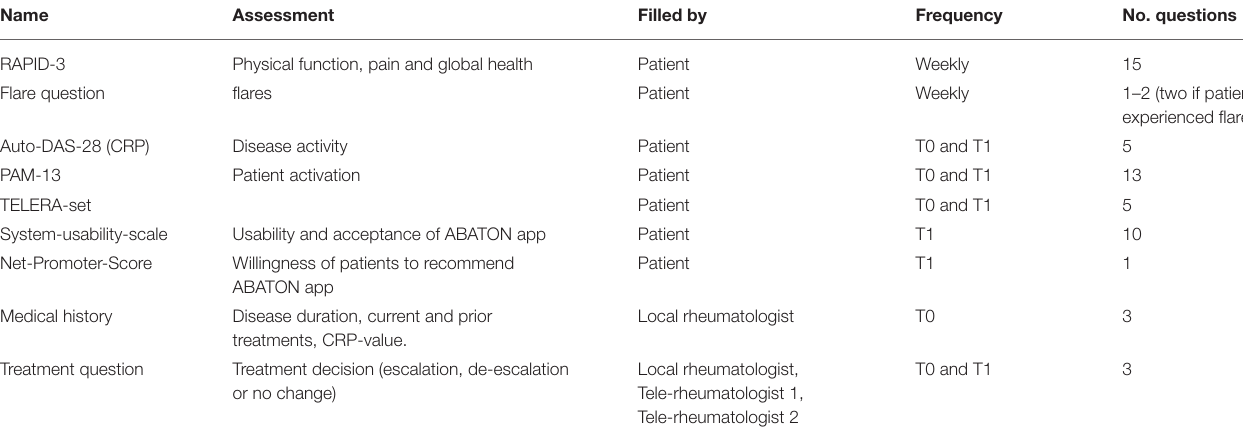
TABLE 1 | Overview of questionnaires and data entered into ABATON software by patients, local rheumatologists and tele-rheumatologists.